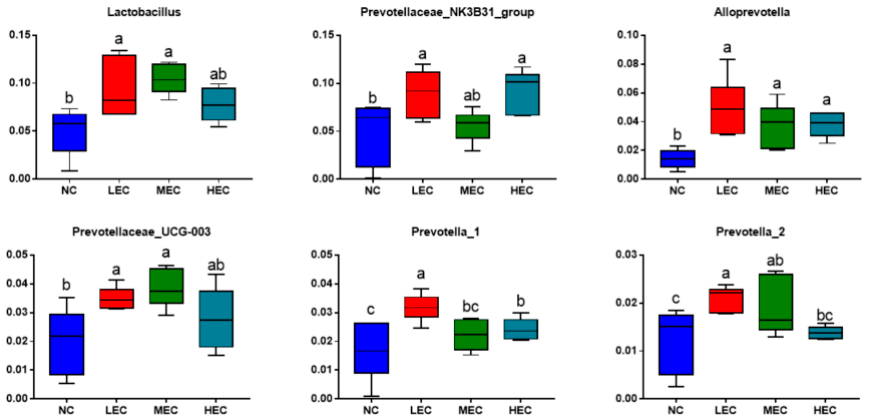
Figure 3. Genus with significant differences in the top 15 from the fecal samples of piglets in experiment 2 ( n = 6). Different superscripts indicate significant differences ( p < 0.05). a,b values differ significantly ( p <